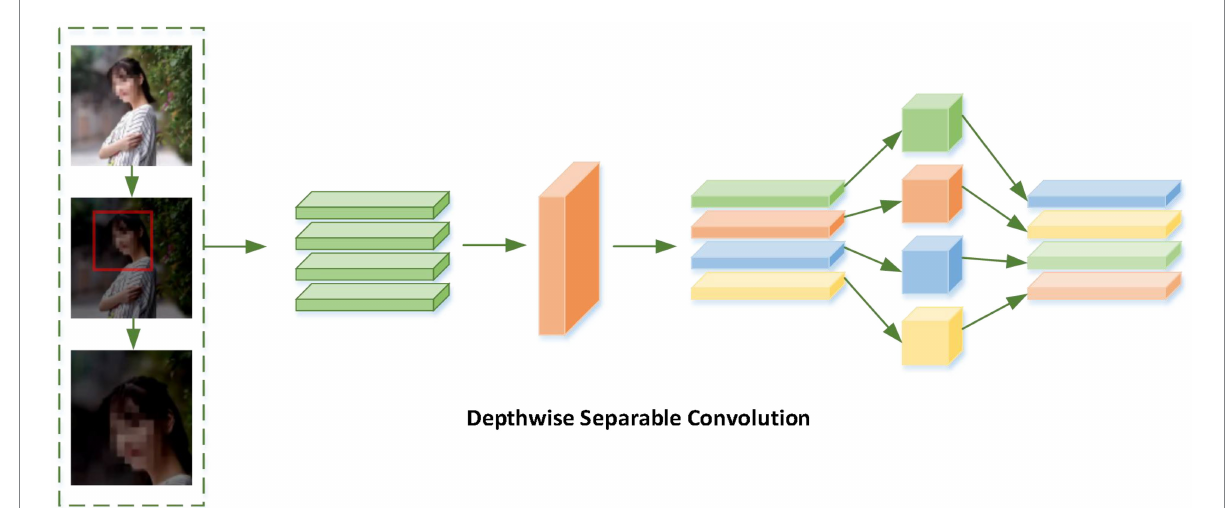
FIGURE 3 Bi-GRU process.